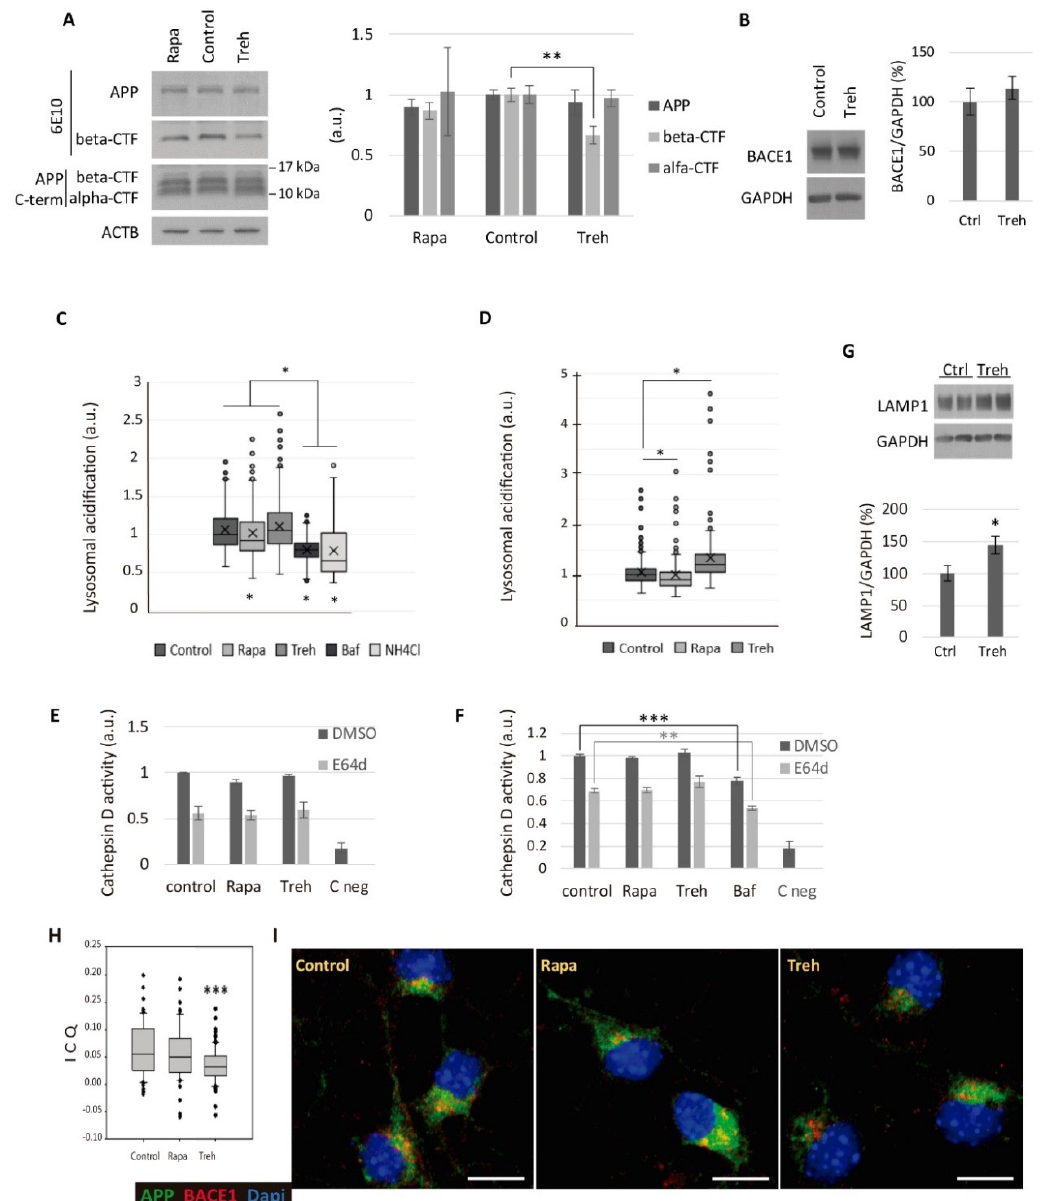
Figure 4. Trehalose diminished the amyloidogenic processing of APP in CGN cultures. The ( A ) CGN cultures were treated for 24 h with 100 mM of Treh or 200 nM of rapamycin (Rapa). Western blot analysis of APP, beta-CTF (measured with 6E10 antibody), and alpha-CTF (APP C-term antibody) was conducted. Student’s t-test was performed. The ( B ) western blot analysis of BACE1 levels in CGN cultures treated with 100 mM of trehalose. The ( C , D ) CGN cultures were treated for 4 h with 200 nM of rapamycin, 100 mM of trehalose, 100 nM of bafilomycin A1 (Baf) or 15 mM of NH4Cl ( C ); or for 24 h with 200 nM of rapamycin or 100 mM of trehalose ( D ). During the last hour of treatment, CGNs were incubated with the acidotropic probe LysoSensor™ Green DND-189 to determine the acidification level of the endo-lysosomal system with an inverted fluorescence microscope. One-way ANOVA on ranks was performed. The ( E , F ) cathepsin D activity assay of CGN cultures treated for 24 h with 200 nM of rapamycin or 100 mM of trehalose ( E ); or for 4 h with 200 nM of rapamycin, 100 mM of trehalose or 100 nM of bafilomycin A1 ( F ). C neg: blank solution. Two-way ANOVAs were performed. The ( G ) western blot analysis of LAMP1 levels after treating CGN cultures with 100 mM trehalose for 24 h. Student’s t-test was performed. The ( H , I ) colocalization analysis of APP (22C11, green) and BACE1 (red) in CGN cultures treated for 24 h with 200 nM of rapamycin or 100 mM of trehalose. The intensity correlation analysis (ICA) algorithm was employed to deter- mine the intensity correlation quotient (ICQ) in ImageJ software. Student’s t-test was performed. Nuclei were stained with DAPI. Scale bar: 10 μ m. Seventy neurons were quantified per experimental condition. (* p ≤ 0.05; ** p ≤ 0.01; and *** p ≤ 0.001). Bars represent mean ± SEM. Box plots represent 10th, 25th, 50th, 75th, and 90th percentiles as boxes and error bars, while outliers are represented as dots.